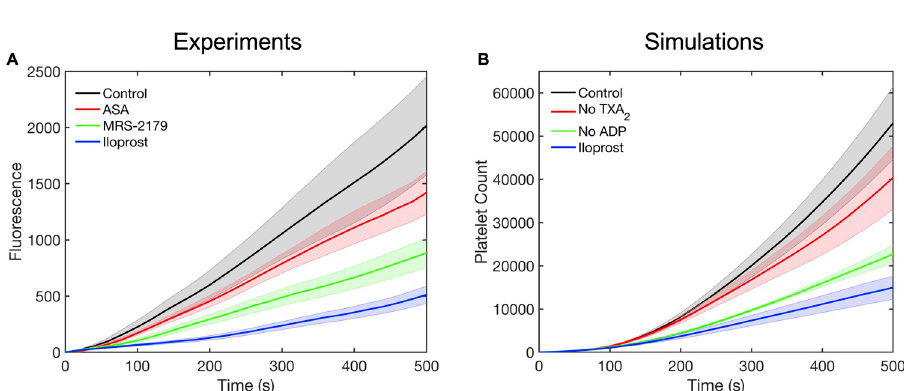
Fig 5. Comparison between thrombus growth dynamics observed in experiments and multiscale simulations under different agonist conditions. (A) Measured platelet deposition in the presence of aspirin, indomethacin, MRS 2179 and iloprost treatment by Flamm et al. and (B) corresponding multiscale simulations with no TXA 2 , no ADP and iloprost